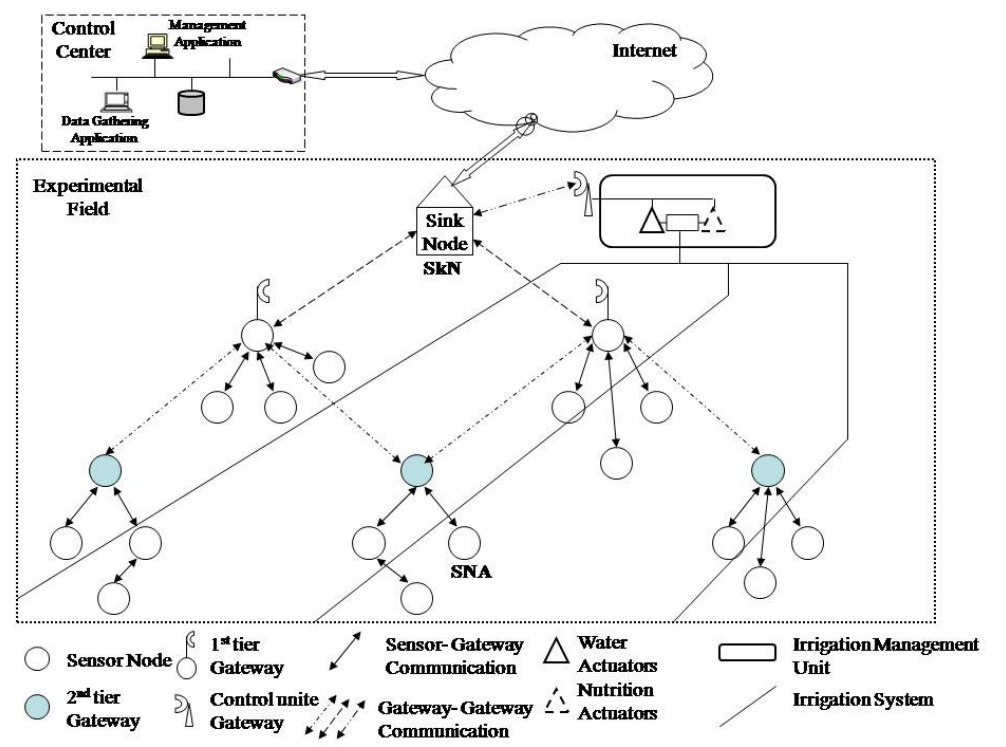
Figure 4. The architecture of the observed experimental field.